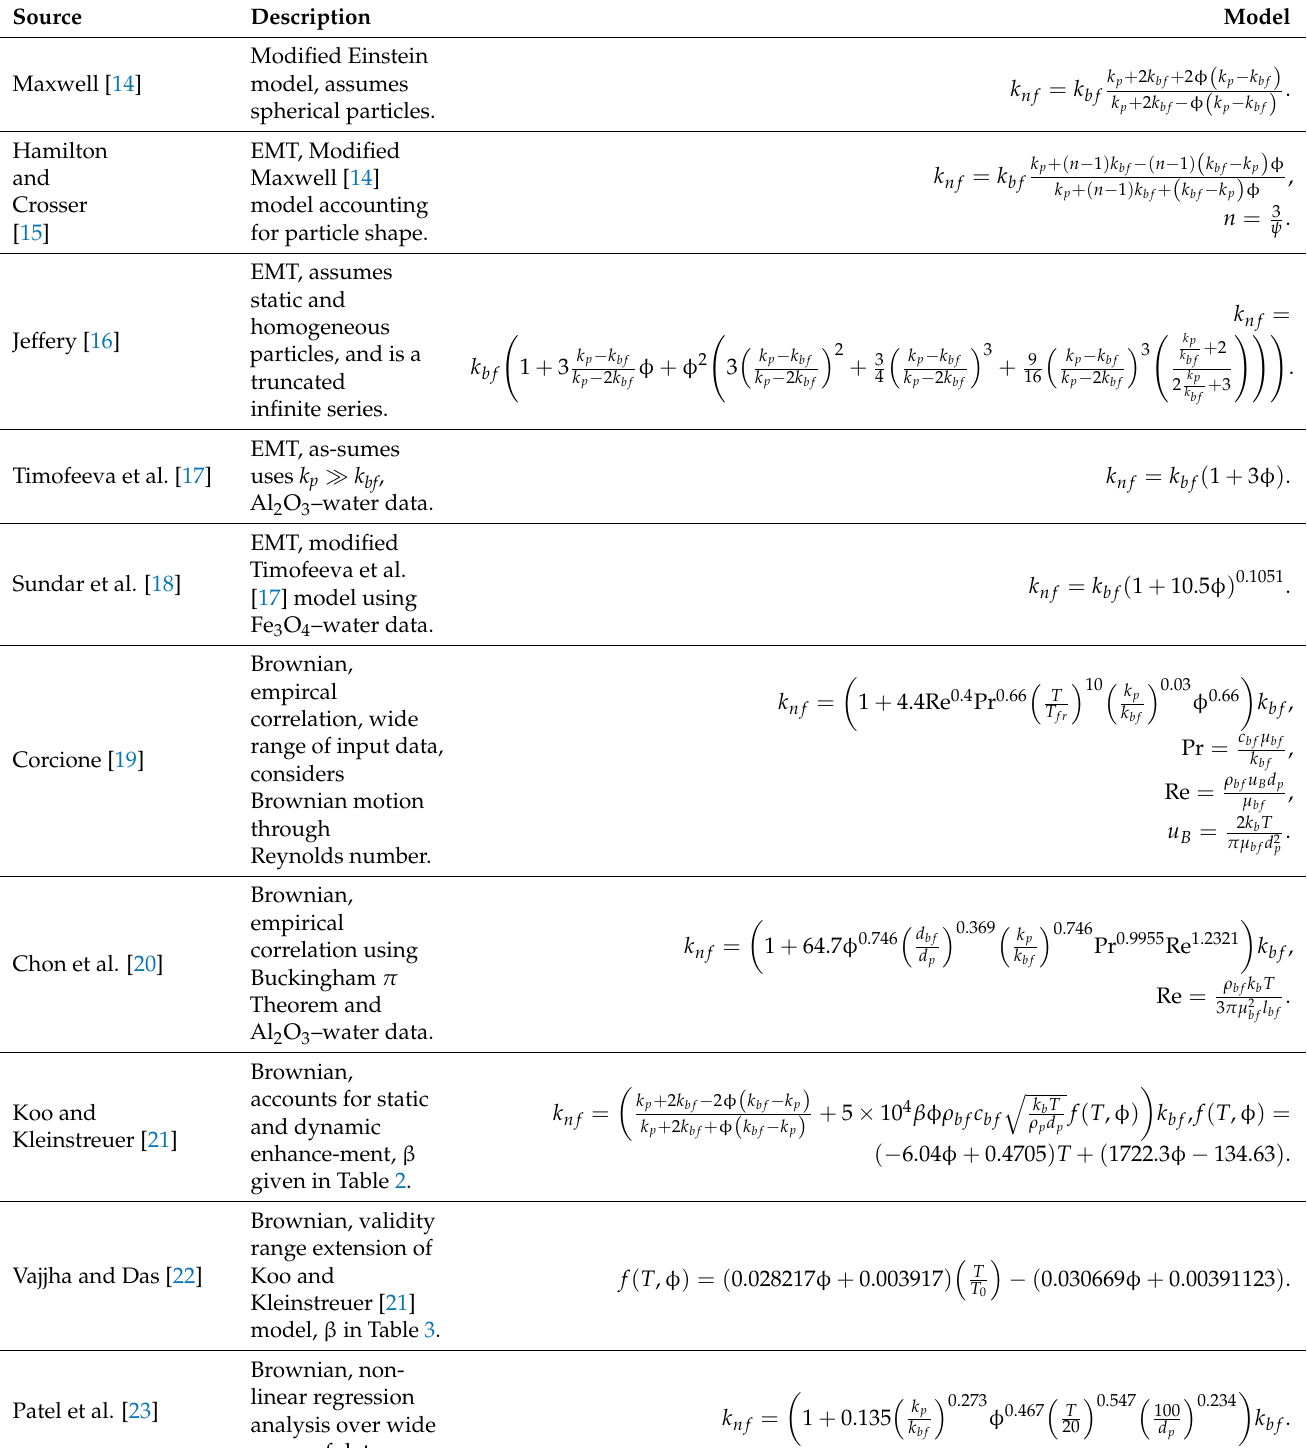
Table A2. Summary of nanofluid thermal conductivity